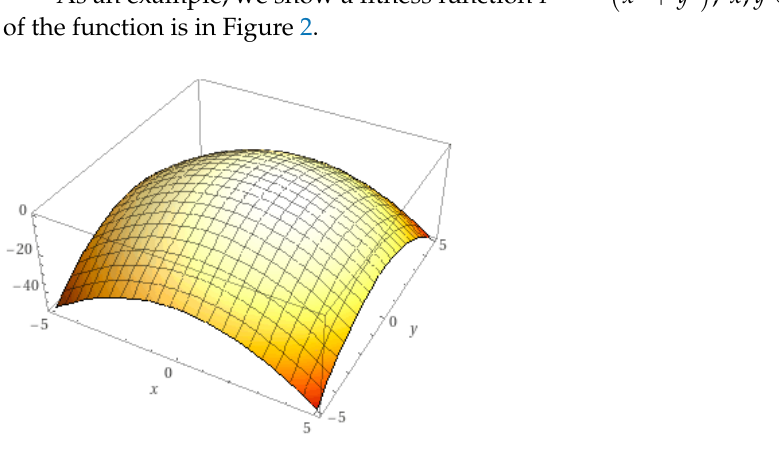
Figure 2. Three-dimensional (3D) plot of the function F